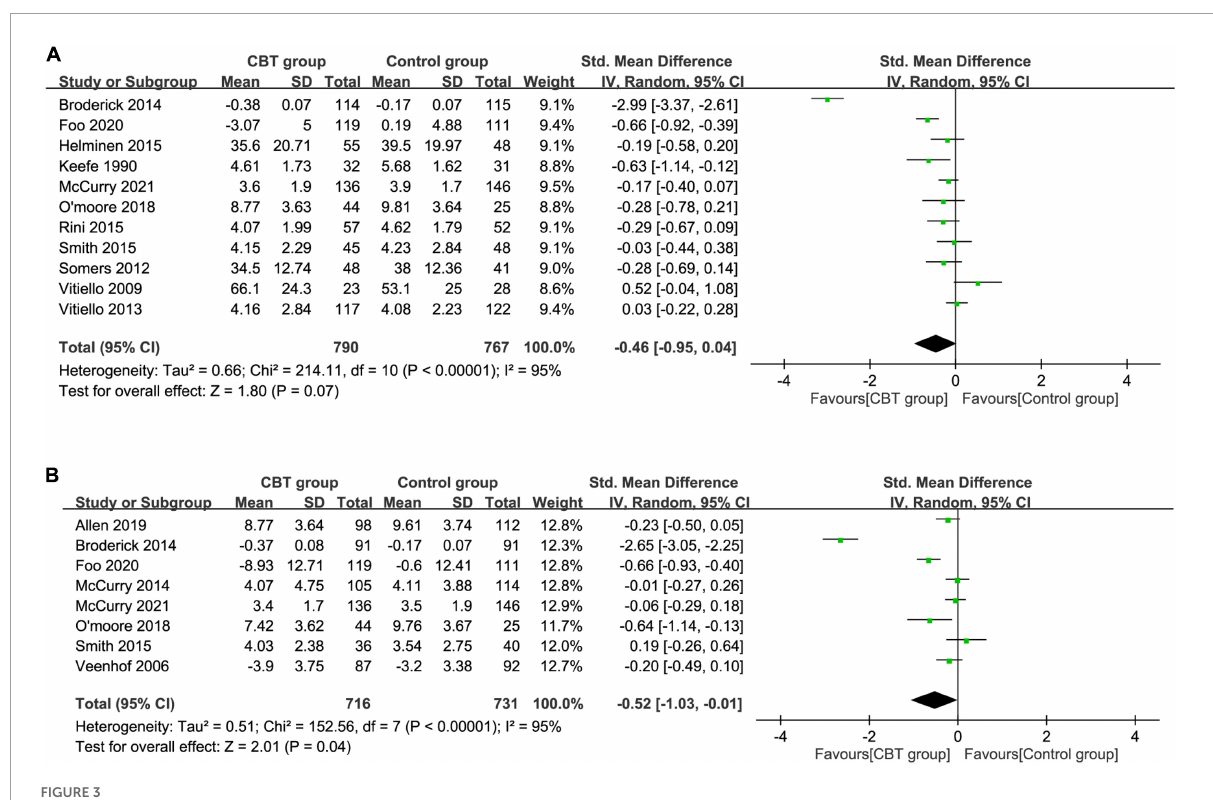
FIGURE3 Forest plot comparing pain severity (A) immediately after treatment and (B) during follow-up period between the cognitive behavior therapy (CBT) and control groups. Std, standardized; iv, inverse variance; CI, confidence interval.